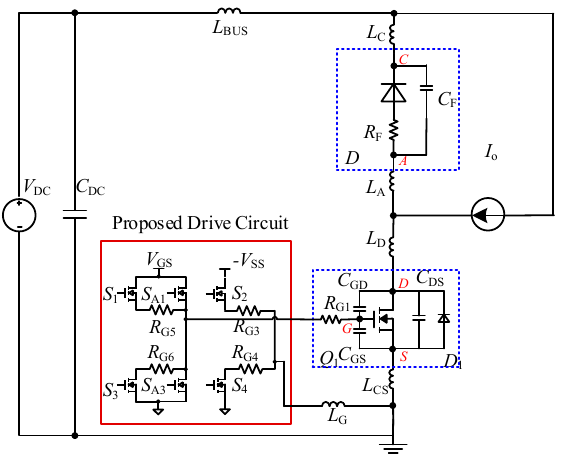
Figure 4. Double-pulse circuit based on the proposed gate driver.